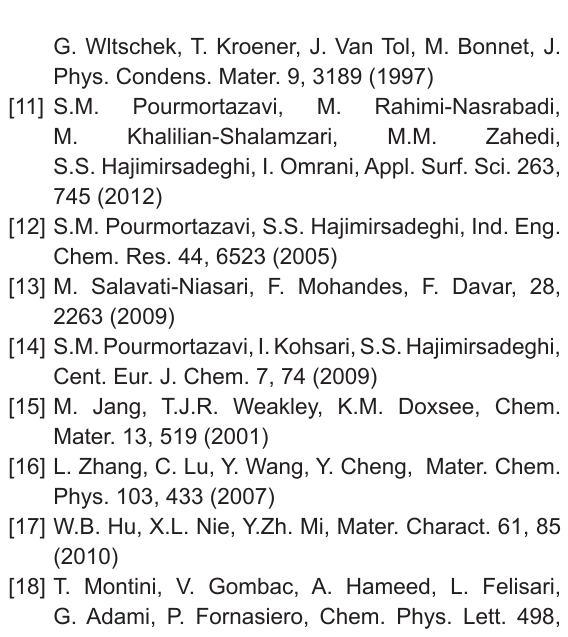
nanoplates prepared via precipitation 4